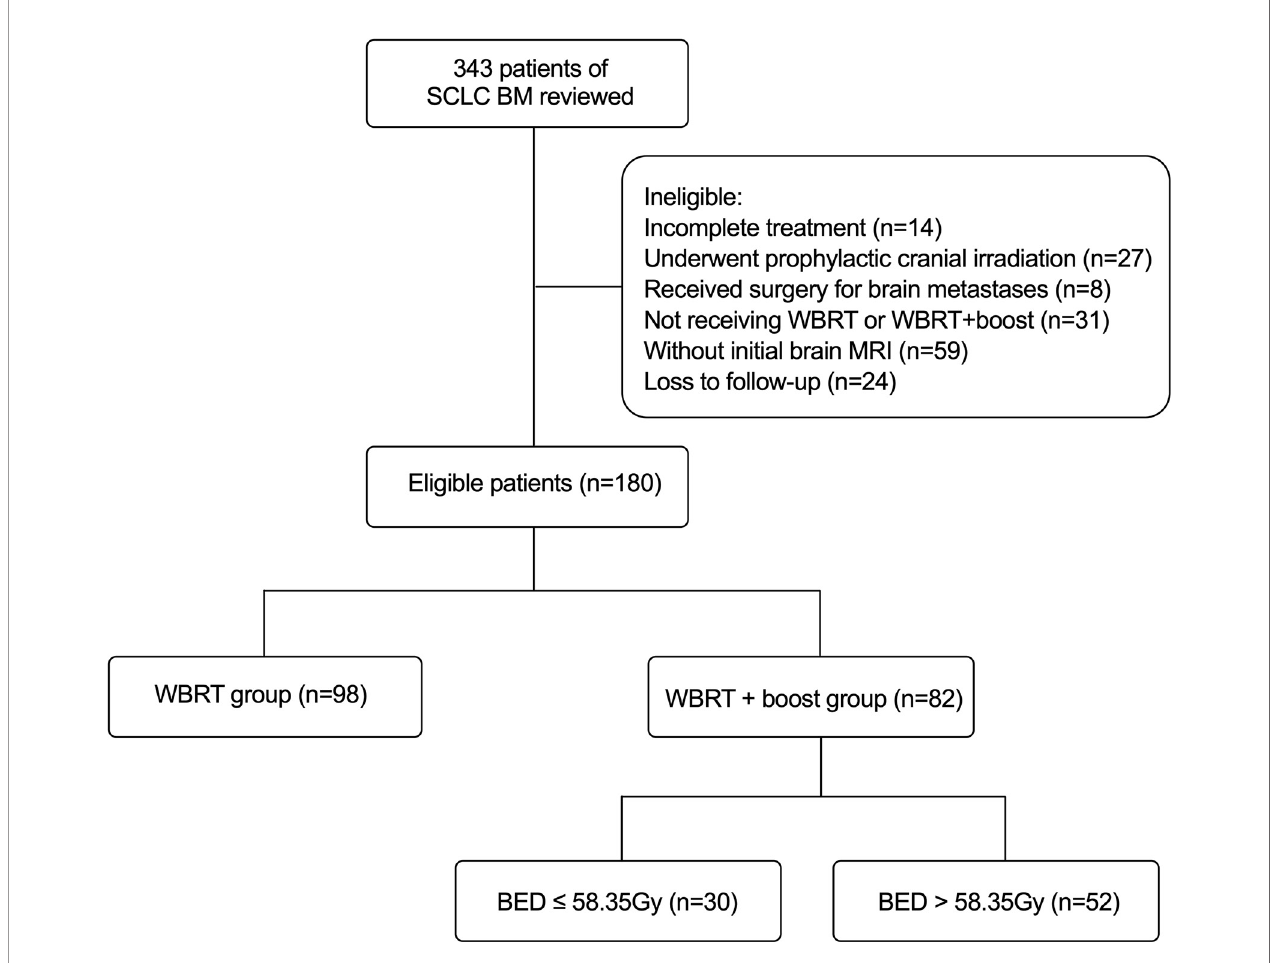
FIGURE 1 | The fl owchart of patient